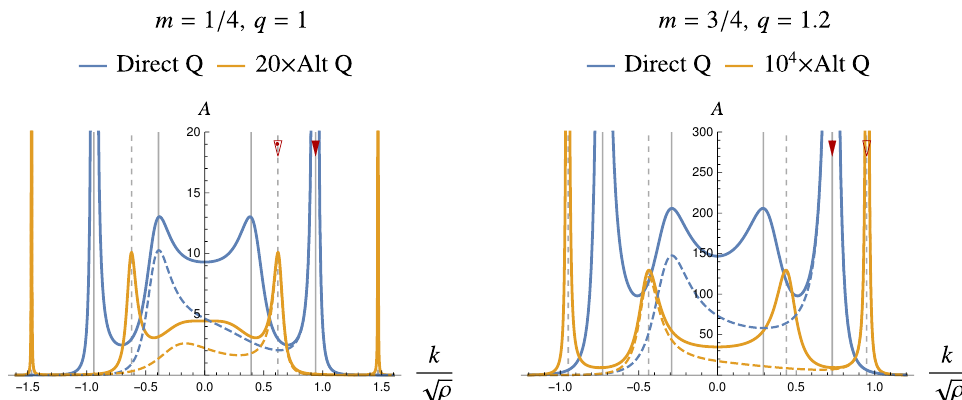
p Figure 3 . The fermionic spectral density near the Fermi level ( ! = 0 : 01 (cid:26) ) in the isotropic Reissner-Nordstr(cid:127)om background (3.1) . The k y = 0 cuts in linear scale of the direct and alternative quantization pictures are shown. The left panel corresponds to the fermionic mass m = 1 = 4 < 1 = 2, where the alternatively quantized dual CFT is well de(cid:12)ned, while the right panel corresponds to the case m = 3 = 4 > 1 = 2, where it does not exist. In both cases the clear peaks corresponding to the well de(cid:12)ned Fermi surfaces are seen in both direct and alternative pictures (In case m = 3 = 4 one needs larger value of fermionic charge q = 1 : 2 in order for the FS to be formed). The dashed lines show the contribution of a single spin component to the spectral density. The red arrows point out the peaks which, if brought close to each other, may be destroyed due to the proximity of the p zero and a pole in the given spin Green’s function. In all cases T= (cid:26) = 0 : 01, which matches the parameters we will use later